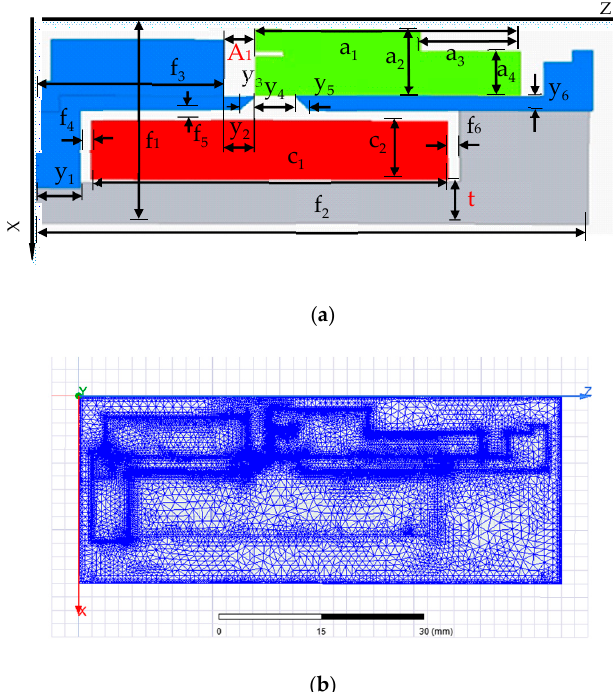
Figure 2. Simplified 2D finite element analysis (FEA) model of linear proportional solenoid (LPS). ( a ) geometry structure and the design parameters; ( b ) the mesh of the 2D FEA model.